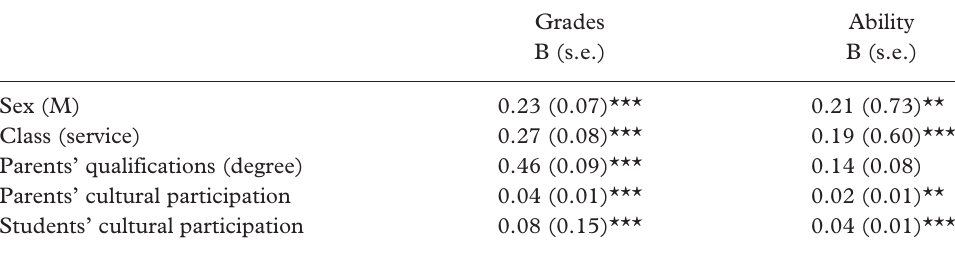
Table 4. Students’ self-predicted grades and estimation of own